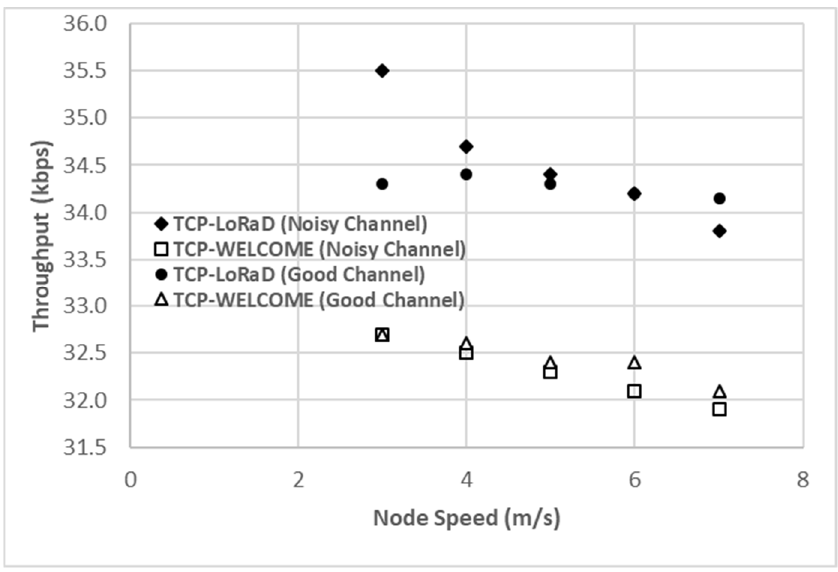
Figure 9. TCP Throughput versus node speed in a noisy channel. Comparison of TCP-